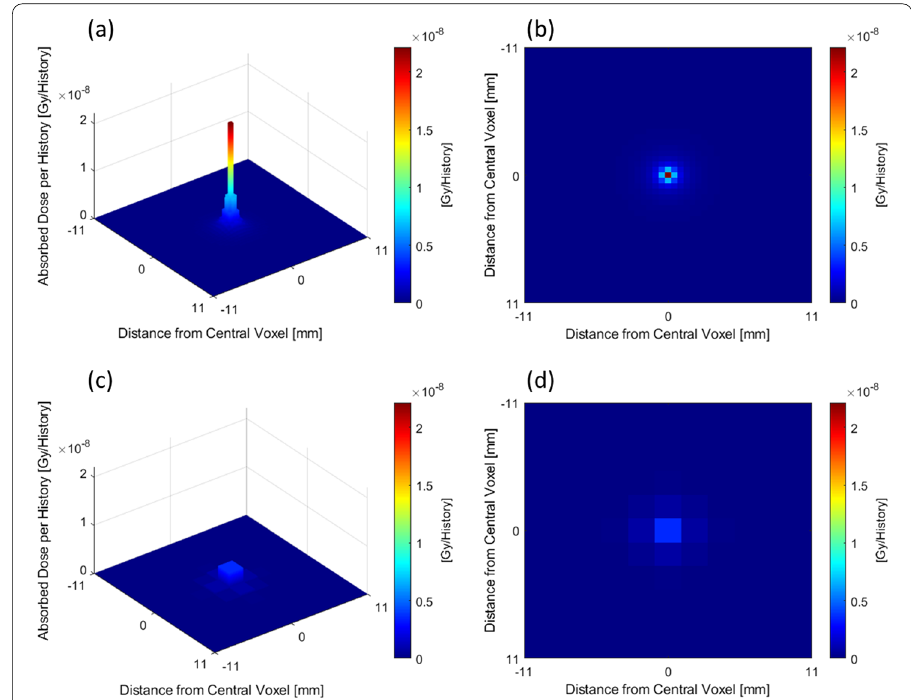
Fig. 8 a 3D surface plot through the central voxel in the CT dose-voxel kernel DVK CT . b 2D cross section through the central voxel in the CT dose-voxel kernel DVK CT . c 3D surface plot through the central voxel in the PET dose-voxel kernel DVK PET . d 2D cross section through the central voxel in the PET dose-voxel kernel DVK PET . The maximum value in all vertical axes and colour bars corresponds to the maximum value of DVK